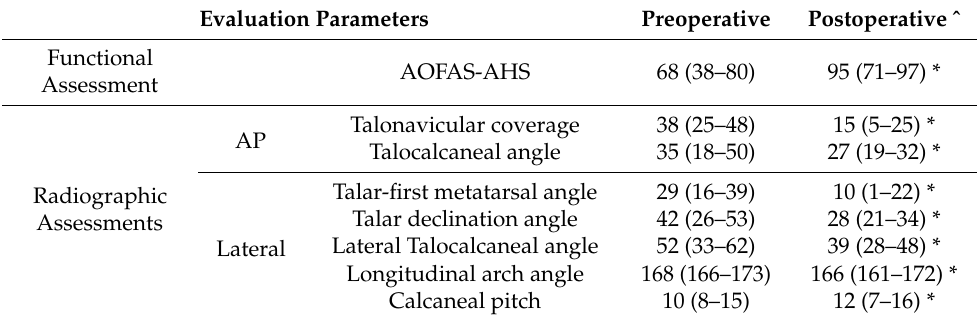
Table 2. The functional and radiographic assessments for patients undergoing SA